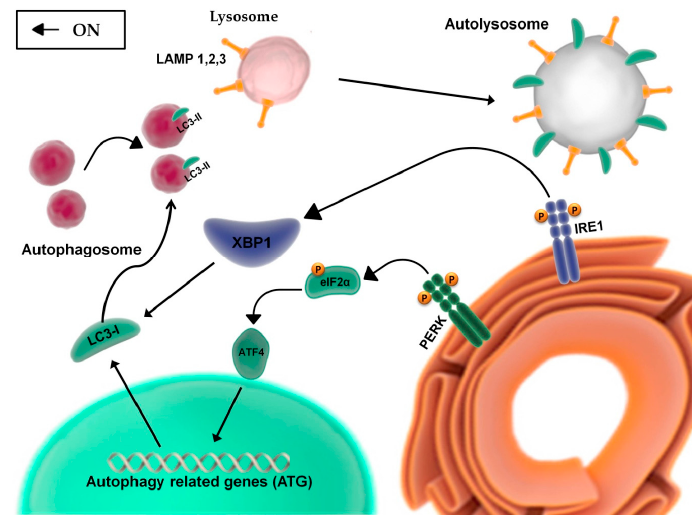
Figure 2. Crosstalk between UPR and autophagy. The autophagic process involves a molecular crosstalk with UPR transducers: (i) PERK/eIF2 α pathway induces the expression of autophagy-related genes through ATF4; and (ii) the activation of XBP1, downstream to IRE1, favors the recruitment of soluble LC3-I to the membranous structures, giving rise to the autophagosome, and to its transformation into LC3-II, the membrane-associated form of LC3-I. The autophagosome complex, conjugated with LC3-II, captures organelles or molecules destined for degradation and merges with lysosome-expressing integral membrane proteins, LAMPs (1,2,3), and this leads to the formation of the autolysosome